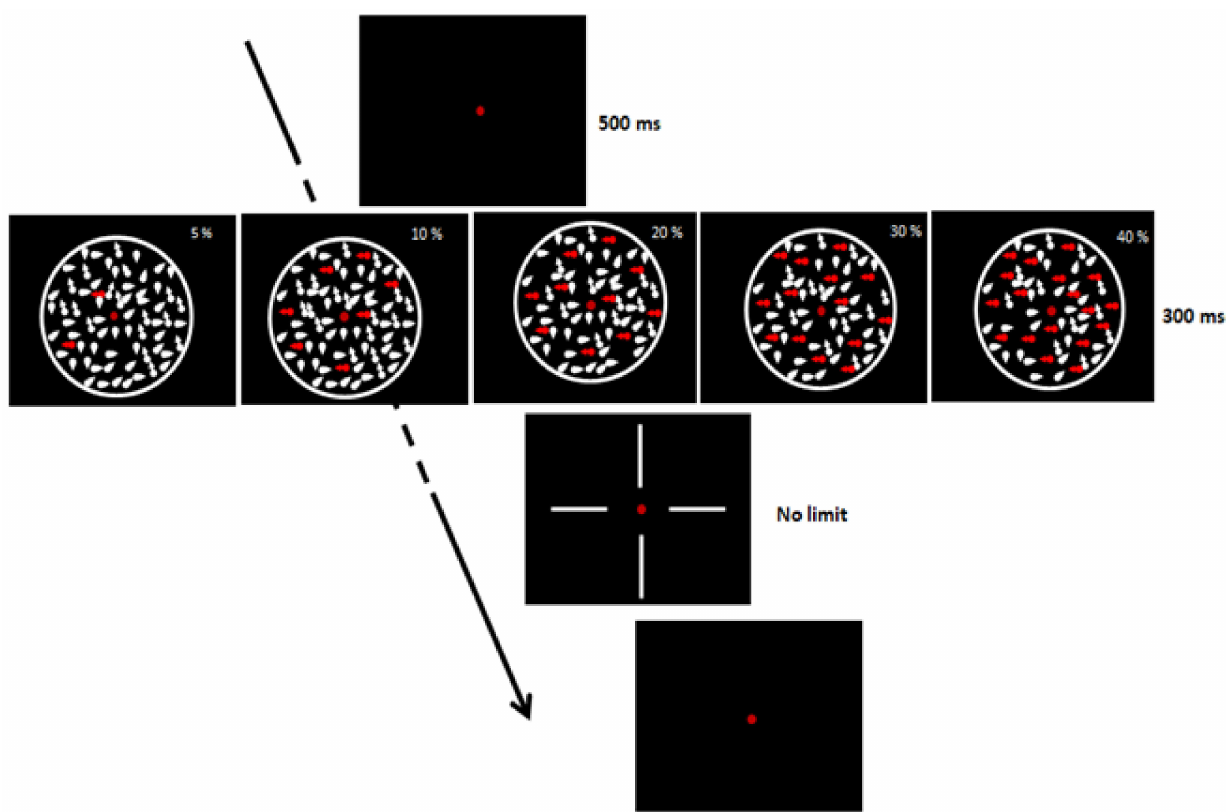
Figure 1. Coherent dot motion